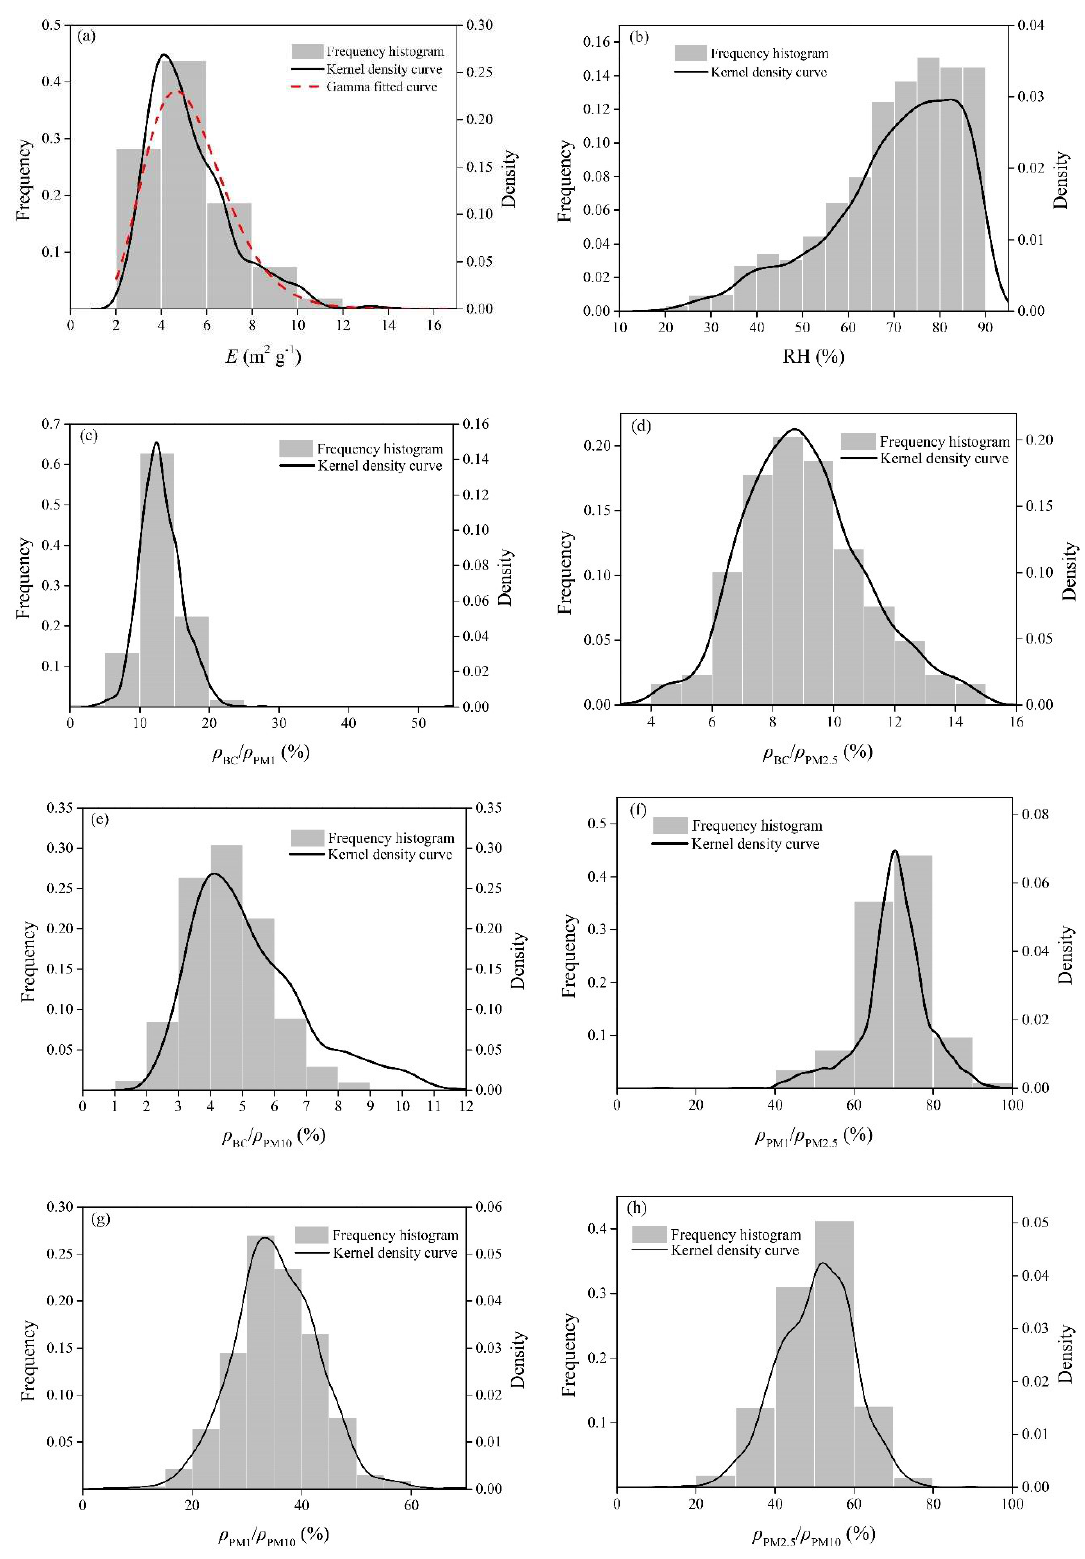
Figure 2. Frequency histogram and Kernel density curve. ( a – h ) represent the frequency histogram and kernel density curve of E , RH, ρ BC / ρ PM1 , ρ BC / ρ PM2.5 , ρ BC / ρ PM10 , ρ PM1 / ρ PM2.5 , ρ PM1 / ρ PM10 and ρ PM2.5 / ρ PM10 , respectively.